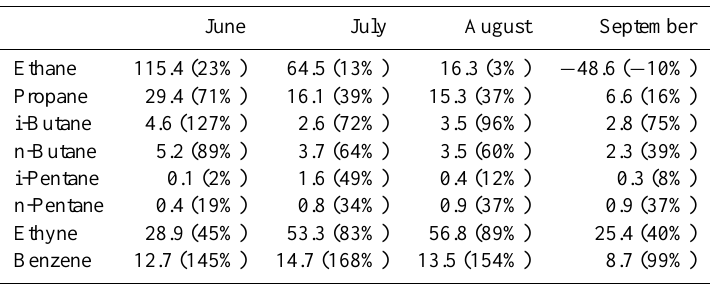
Table 2. Enhancements of NMHC during summer months relative to May/October. Differences are given in pptv and represent the difference between monthly means; enhancement is shown in parentheses.